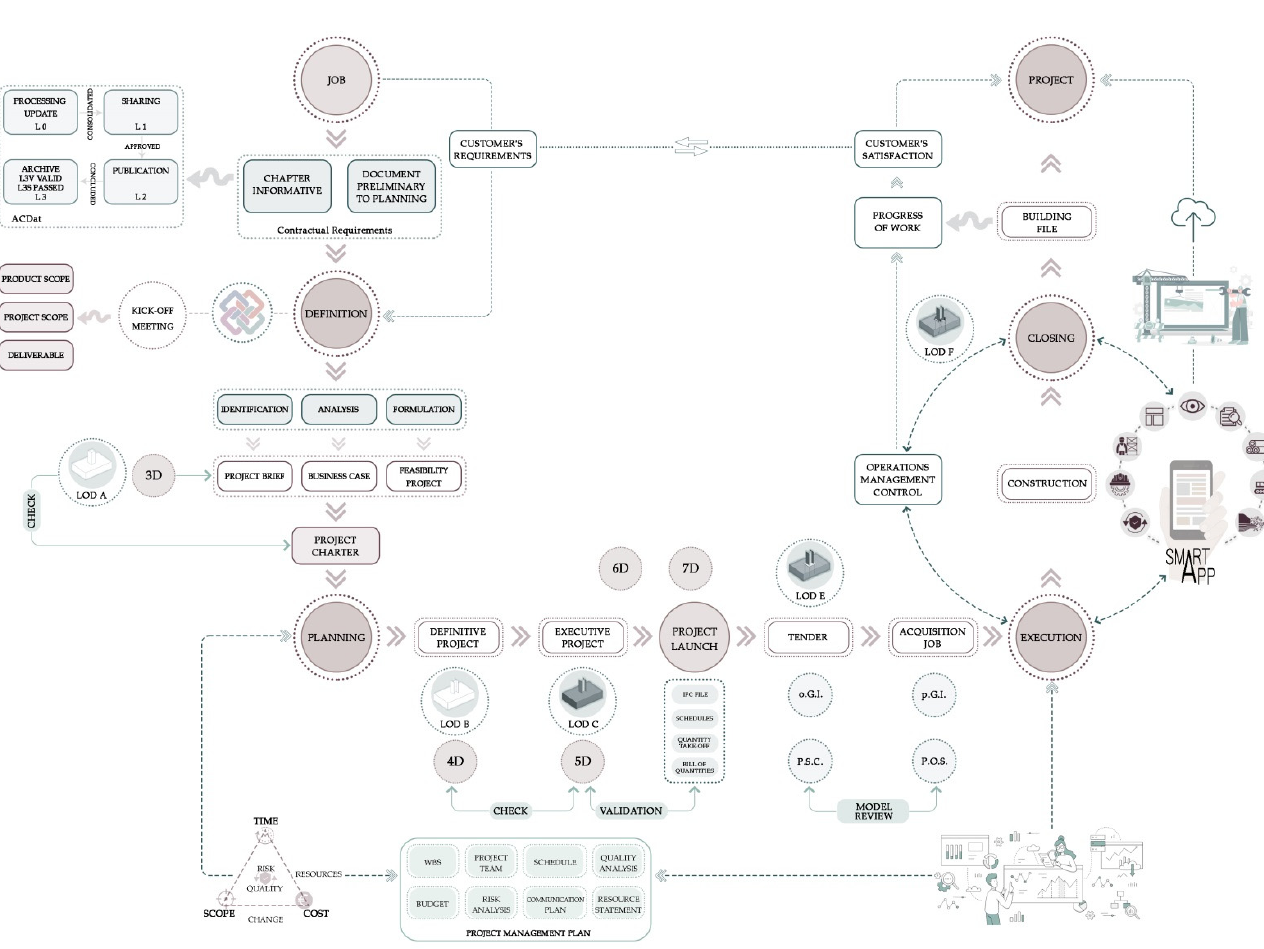
4 of 19 Table 1. Research data. Query string